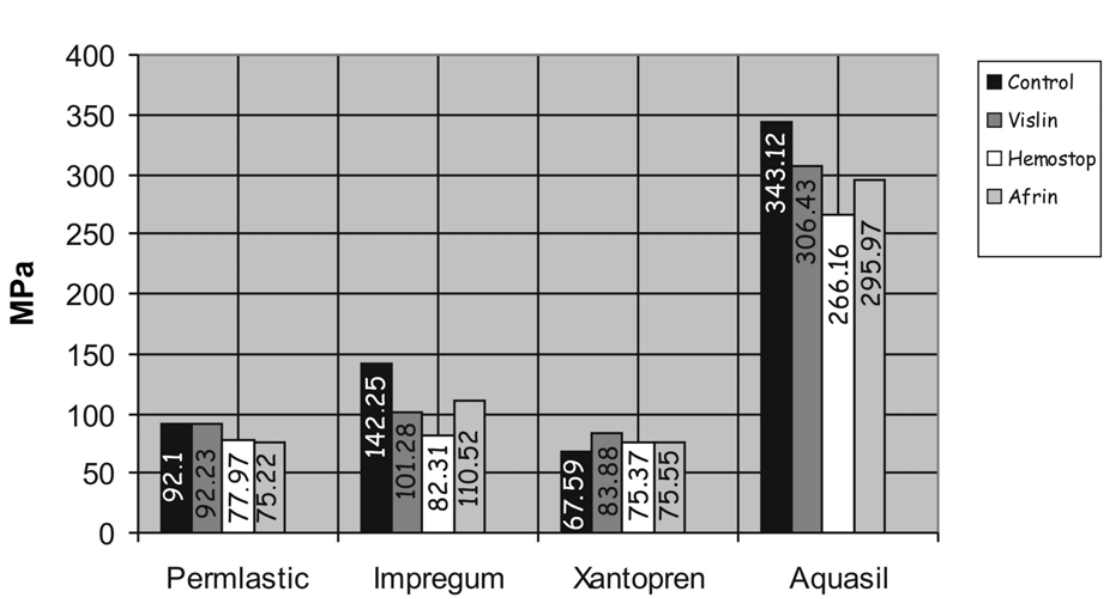
FIGURE 1- Tensile bond strength means for the four impression materials polymerized in contact with different gingival retraction